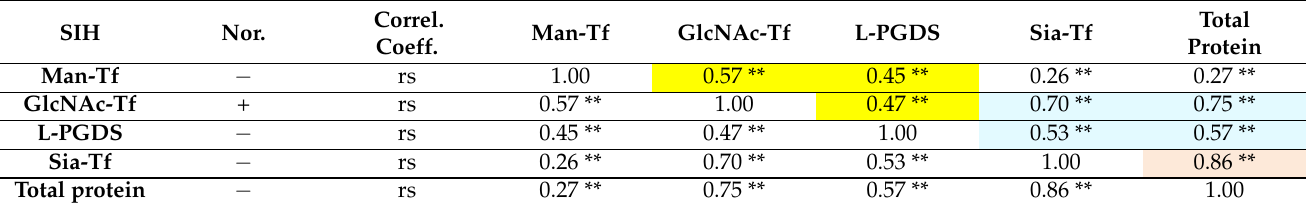
Table 3. Correlation coefficients and data normality of markers.